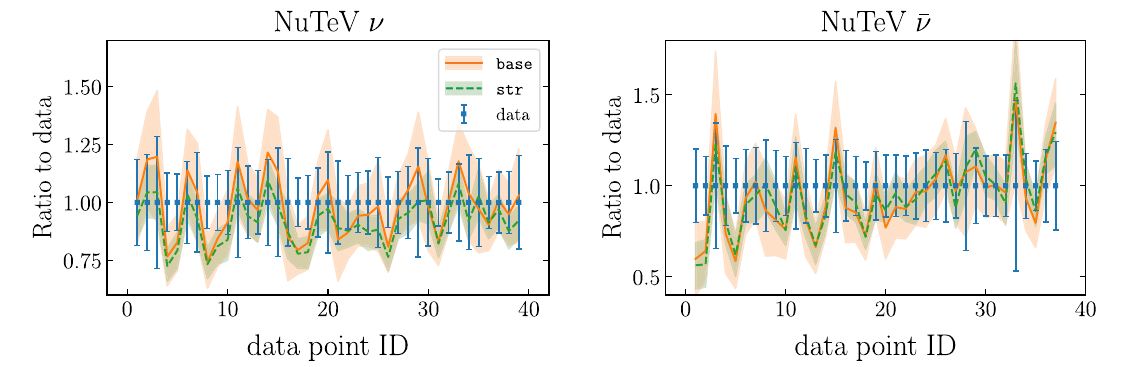
Fig. 3 Comparison between theoretical predictions and experimental data for the neutrino (left) and antineutrino (right) charm dimuon cross sections measured by the NuTeV experiment [9]. Data and theory are normalized to the central value of the former; data points are sorted by